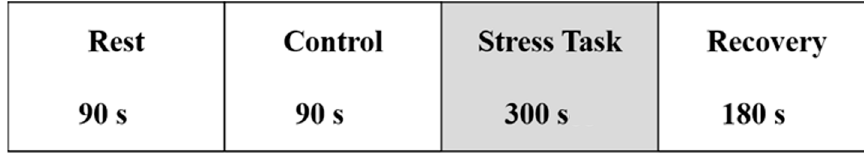
Figure 1. Experimental